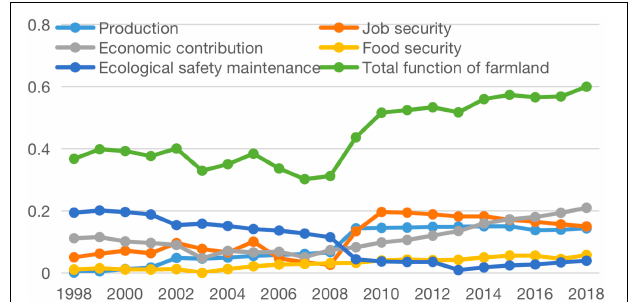
FIGURE 5 | Change trend for cultivated land functions in Henan Province,